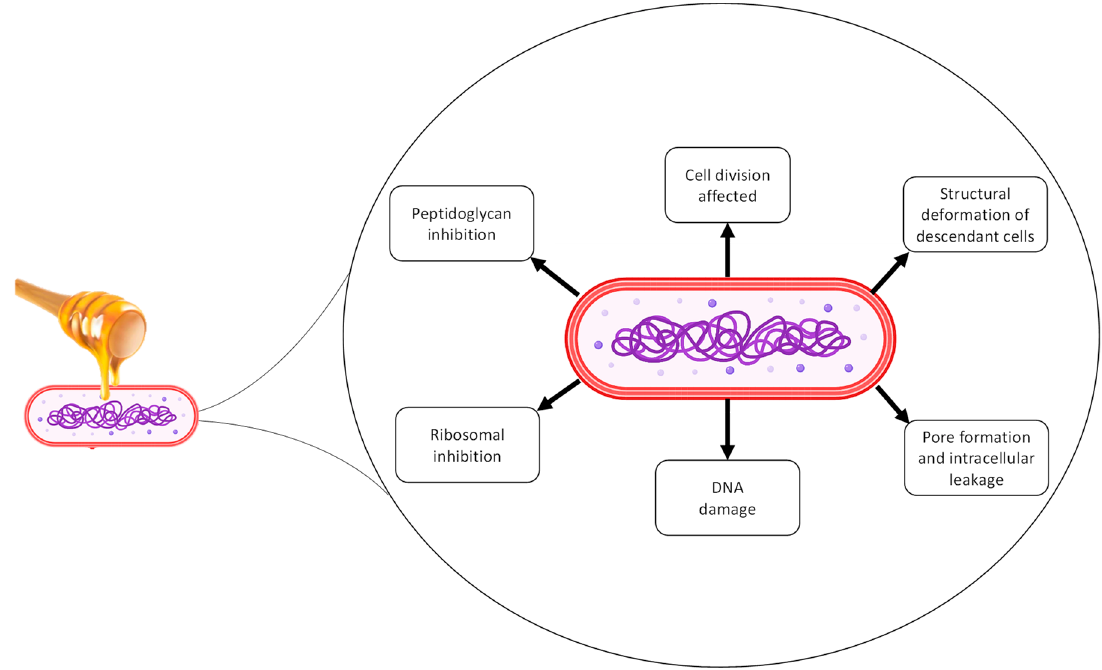
Figure 2. Mechanism of action of honey on bacteria.